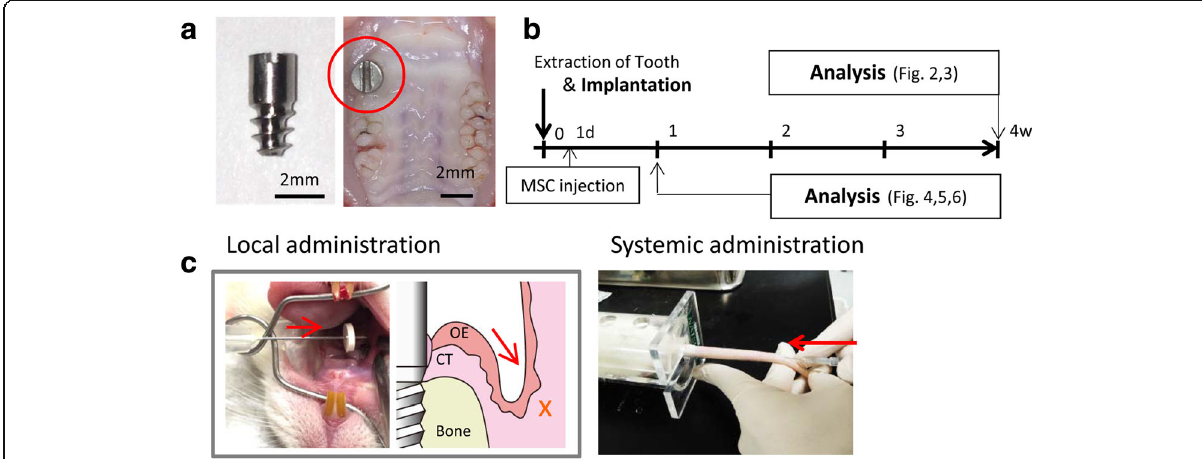
Fig. 1 In vivo experimental design. a Photographs of the experimental implant (left panel) and implant in the rat oral cavity (right panel). b Experimental protocol of in vivo study: Implantation was performed at the same time as tooth extraction, then 1 day after implantation, mesenchymal stem cells (MSCs) were injected via the tail vein or into the gingivobuccal fold around the dental implant. Epithelial tissue structure around the implant was observed after 4 weeks. MSC accumulation into various tissues was observed 1, 3, 5, and 7 days after MSCs injection. c Photograph of MSC administration into the model rat with the experimental